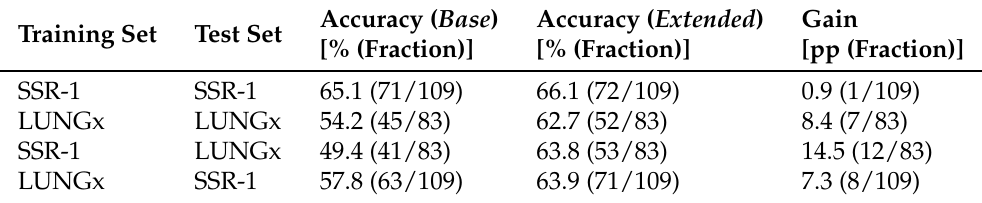
Table 6. Performance of the classification models. Accuracy columns report the percentage (fraction) of the samples of the test set classified correctly; the gain is the difference between the base and extended feature